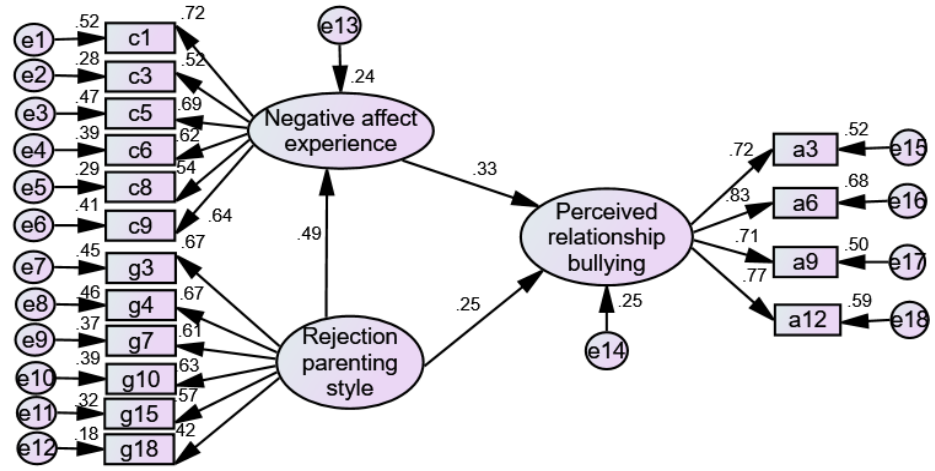
Figure 4. Partial mediating effect of negative affect experience between the rejection parenting style and the perceived relationship bullying. Table 7. The model fitting goodness index table with the perceived relationship bullying as the dependent variable.